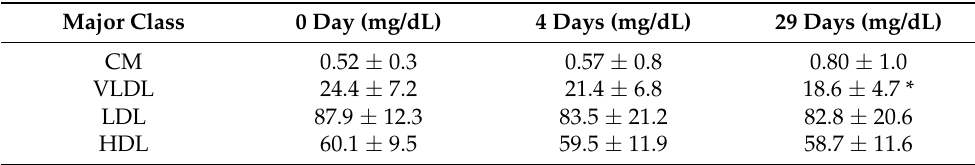
Table 1. Cholesterol concentration in the major classes of lipoproteins.